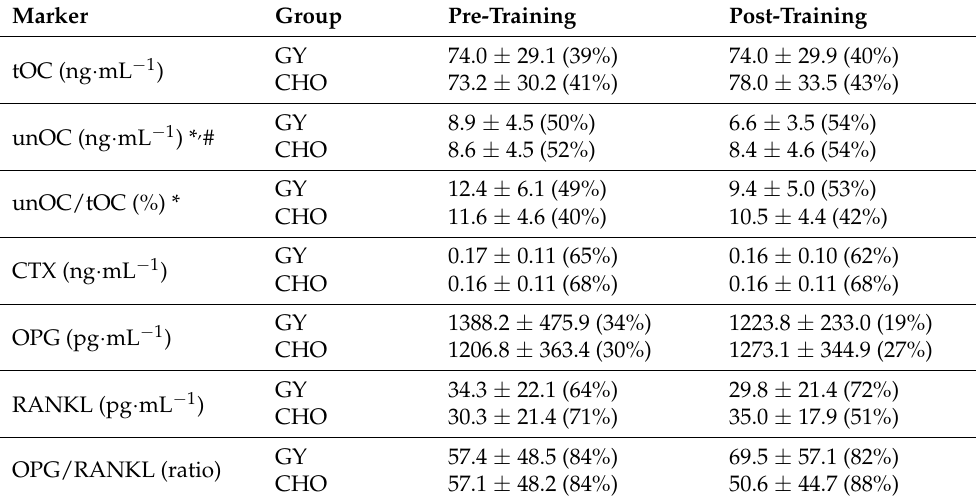
Table 3. Resting, morning concentrations of bone turnover markers and osteokines during each intervention condition in female adolescent soccer